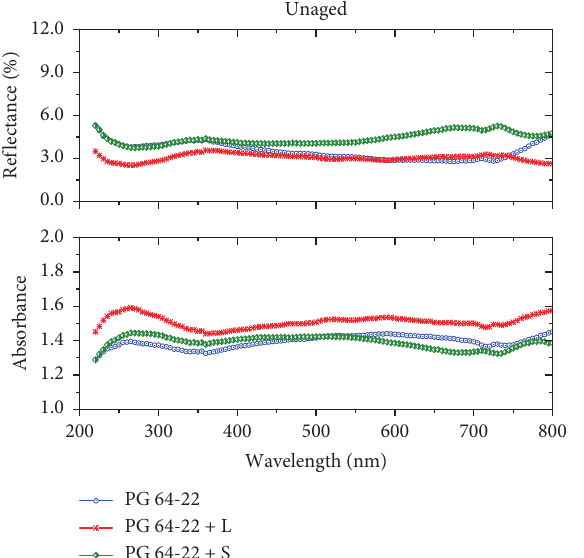
Figure 4: Reflectivity and absorbance of unaged warm CRM binders.